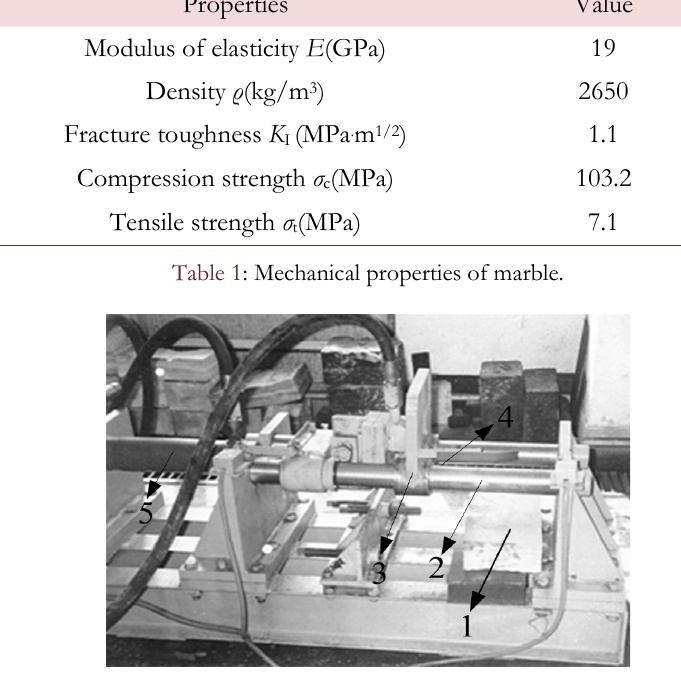
Figure 4: Laboratory furniture of rock cutting linearly: 1-rock specimen; 2-guideways; 3-clamping device of conical pick; 4-conical pick; 5- advancing hydro-cylinder.